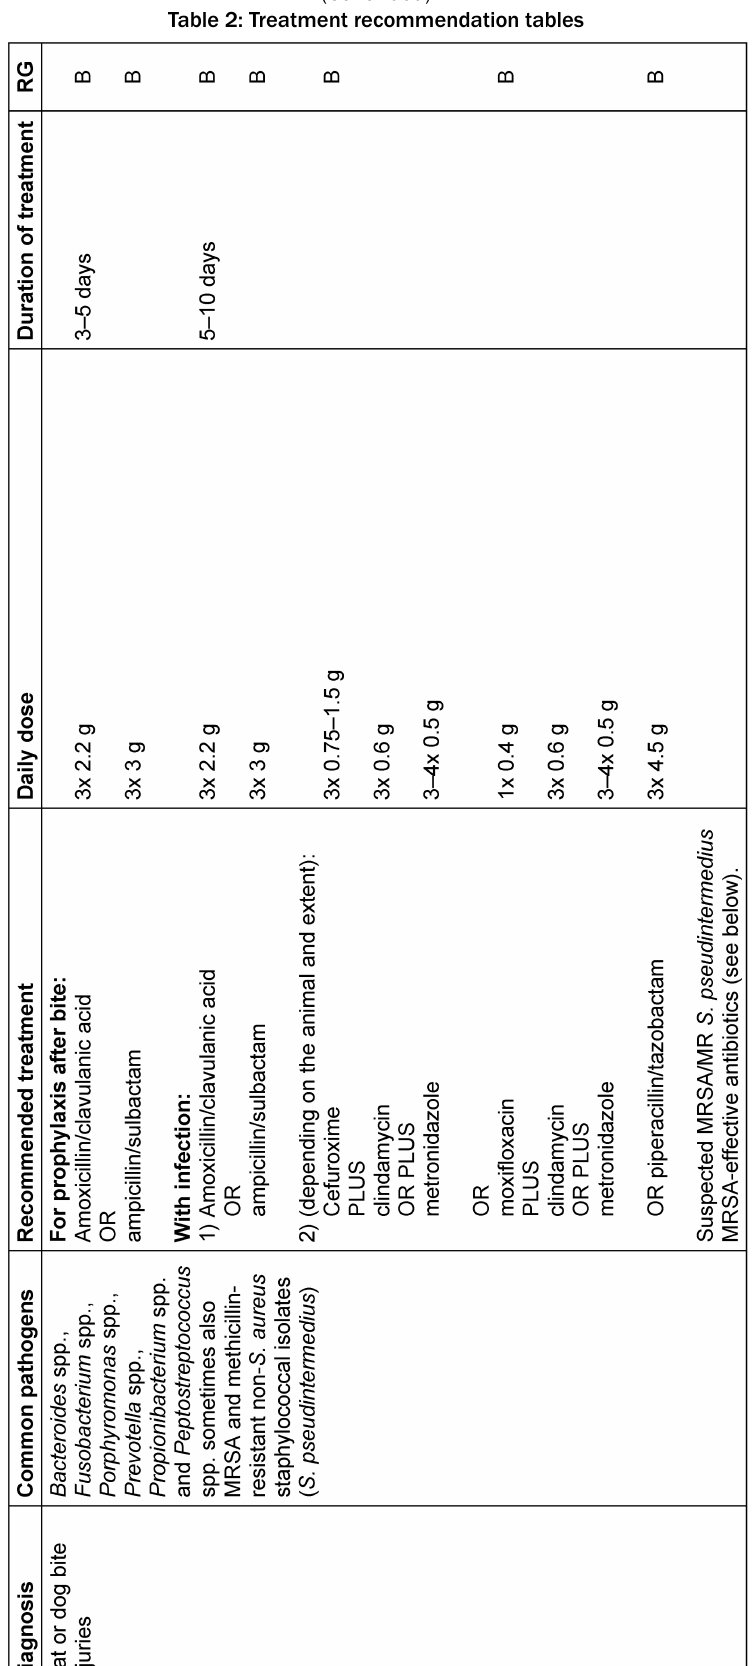
Table 2: Treatment recommendation